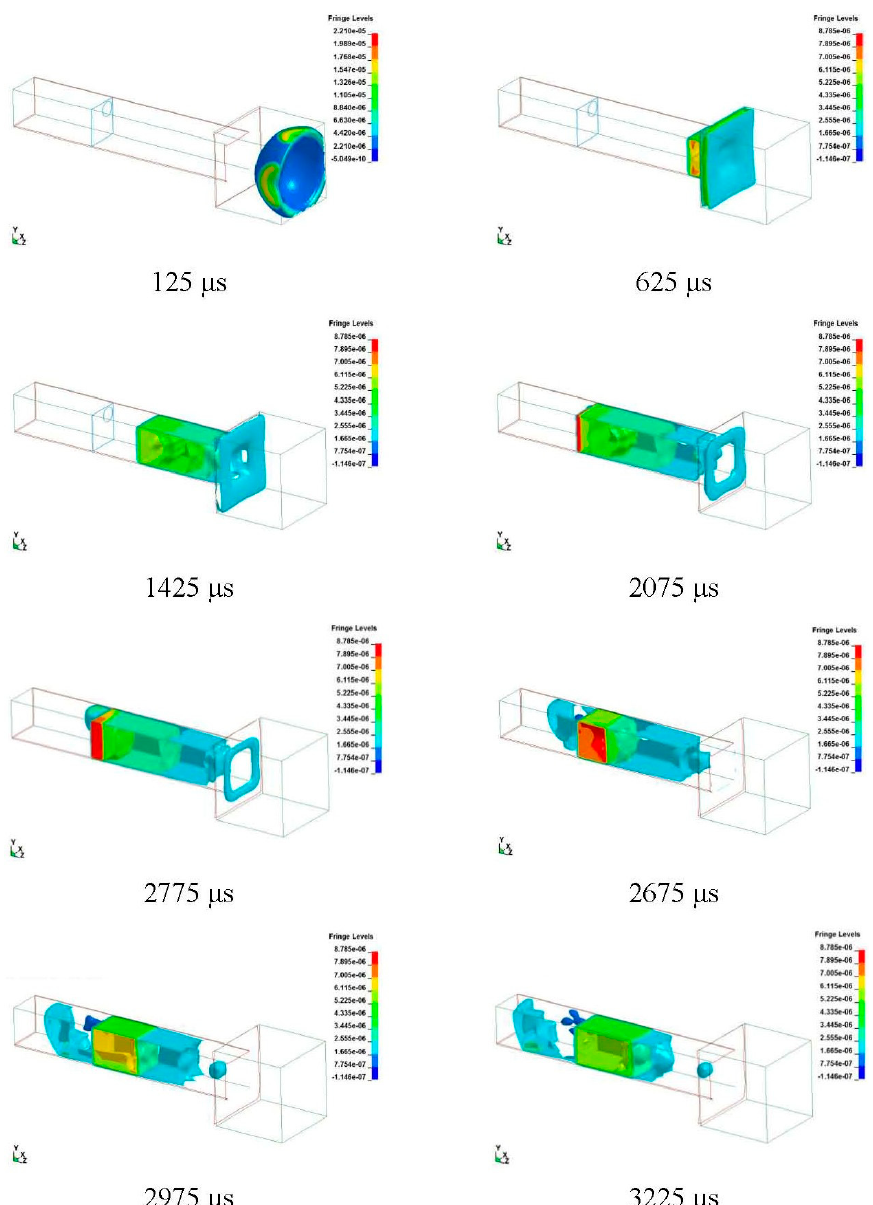
Figure 8. Blast transfer of numerical simulation of linear tunnel with single-pressure relief orifice plate explosion (100 g C-4). The variation of blast attenuation inside the tunnel of this experiment is shown in Figure 9. According to the experimental results, the transfer of the blast inside the tunnel will decrease as the distance increases. In order to know the blast attenuation characteris- tic of the double-pressure relief orifice plate, as designed by reducing the section, we an- alyzed and discussed the blast transfer rate and variation rate of the double-pressure relief